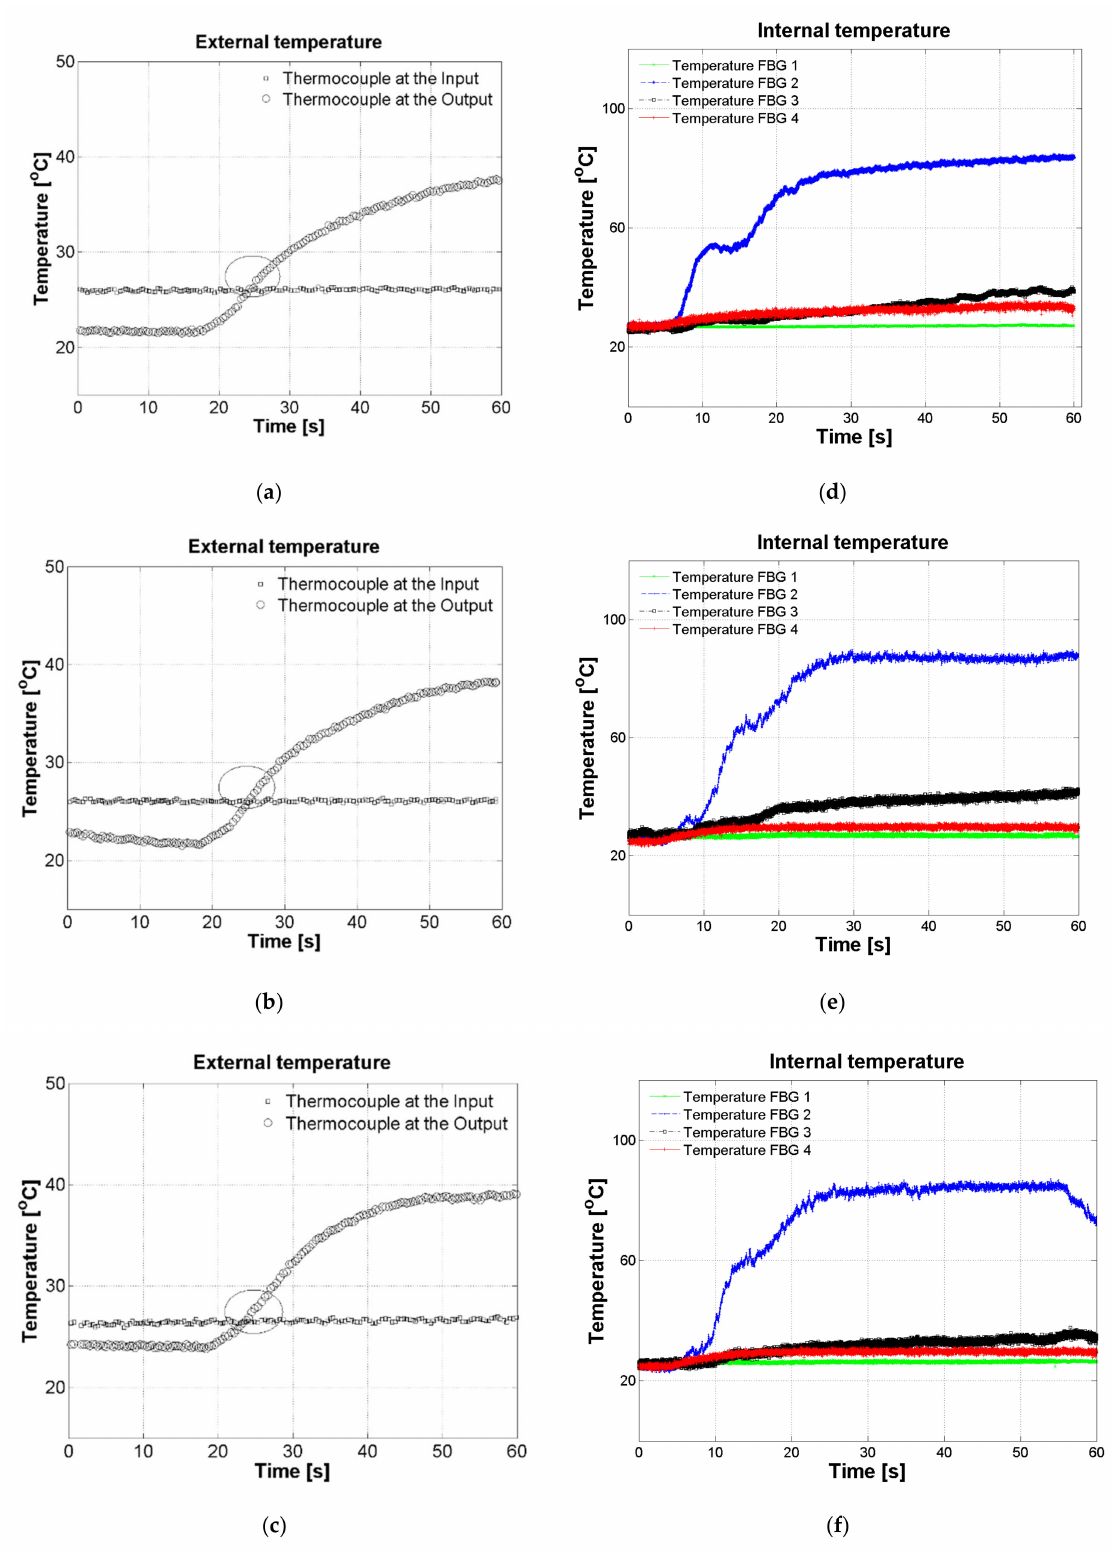
Figure 11. Temperature as function of time using water with dissolved salts. ( a , b , c ) Outer temperatures measured by thermocouples in ( a ): 60 s, ( b ): 60 s, and ( c ): 60 s. Inner temperatures measured by FBG temperature sensors in ( d ): 60 s, ( e ): 60 s, and ( f ): 60 s. Blue and black lines indicate FBG 2, 3 and 4 in contact with the water. Green line indicates FBG 1 the temperature inside the microwave